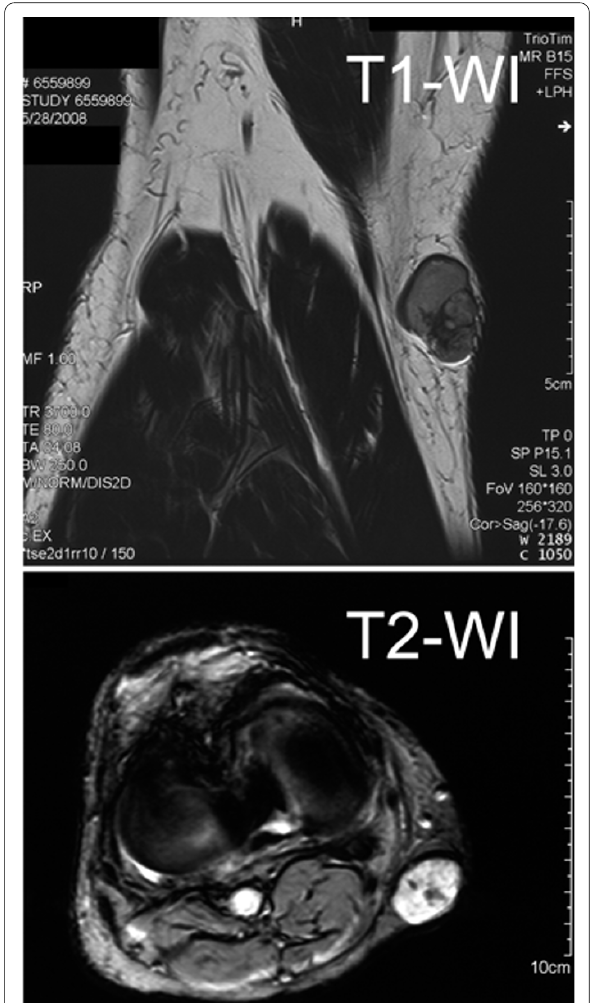
Figure 1 MRI showing a mass lesion embedded in the subcutane- ous tissue on the medial posterior side of the right knee, demon- strating low and high signal intensity in T1- and T2-weighted images (arrows in upper and lower), respectively .